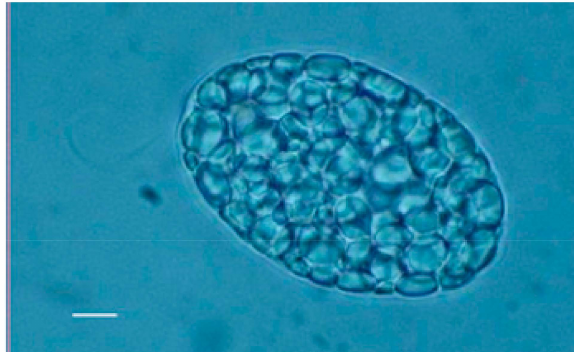
Figure 2. Optical microscopy image of WZSL mutant filled up with paramylon granules. Bar: 10 µ